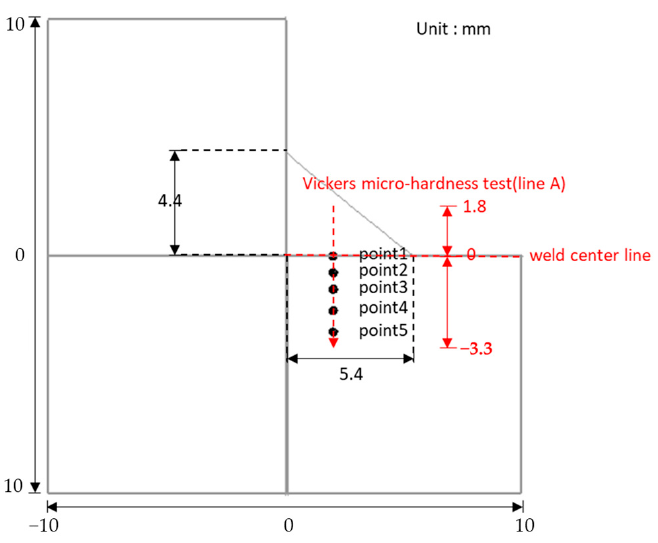
Figure 4. Schematic of welded joint plane and SEM, EBSD analysis positions, and Vickers micro- hardness test line.